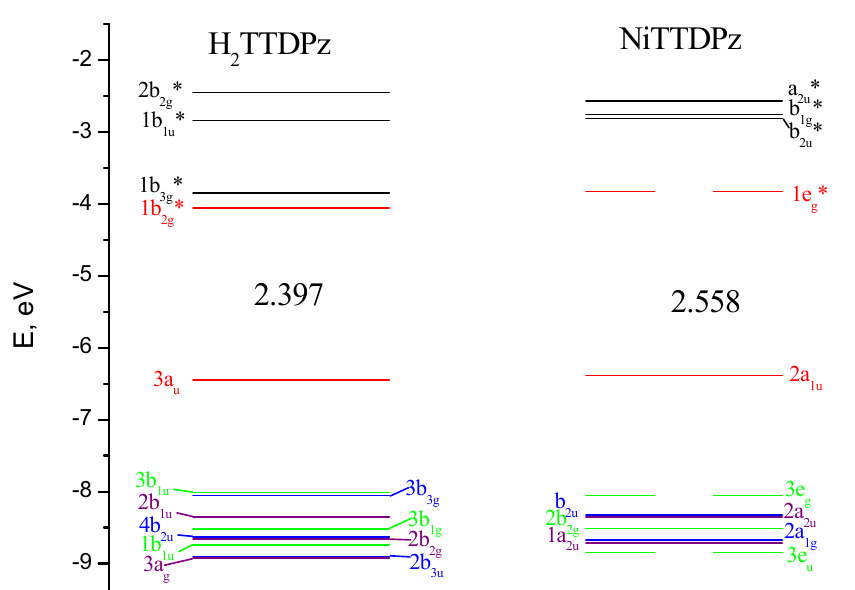
Figure 8. Molecular orbital (MO) level diagram for H 2 TTDPz and NiTTDPz molecules. The values